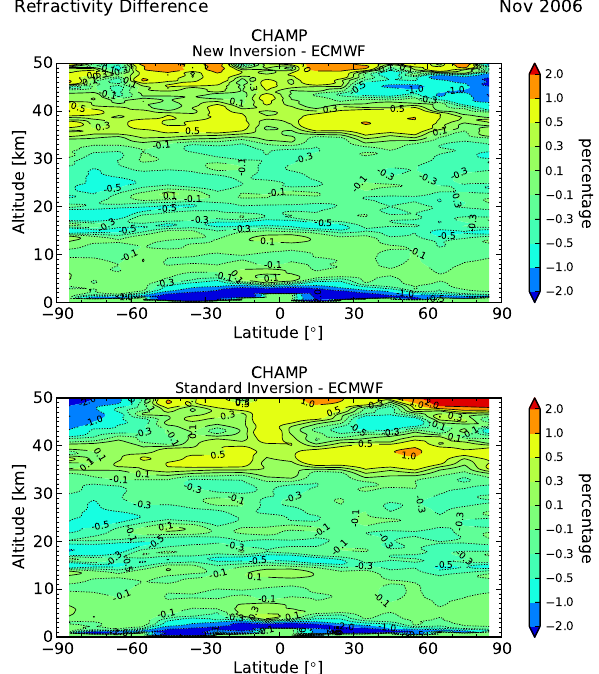
Figure 5. Relative difference between monthly mean refractiv- ity from CHAMP data and from collocated ECMWF data, using Fig. 5 : Relative difference between monthly mean refractivity from CHAMP data and from col- average-profile inversion (top plot) and standard inversion (bottom located ECMWF data, using average-profile inversion (top plot) and standard inversion (bottom plot), for November plot), for November 2007.